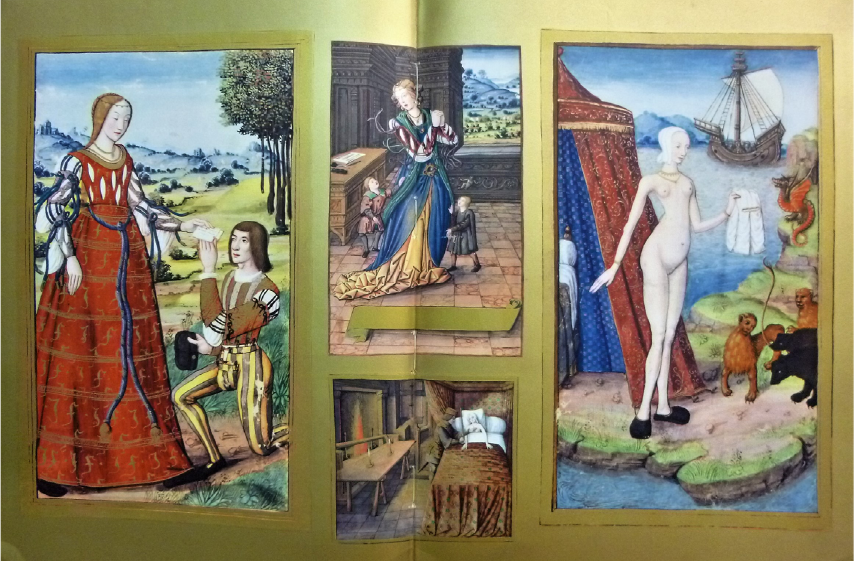
Fig. 3 Héroïnes d’Ovide , miniatures d’un manuscrit médiéval du XVI e siècle, héliogravures parues dans Verve , no. 4